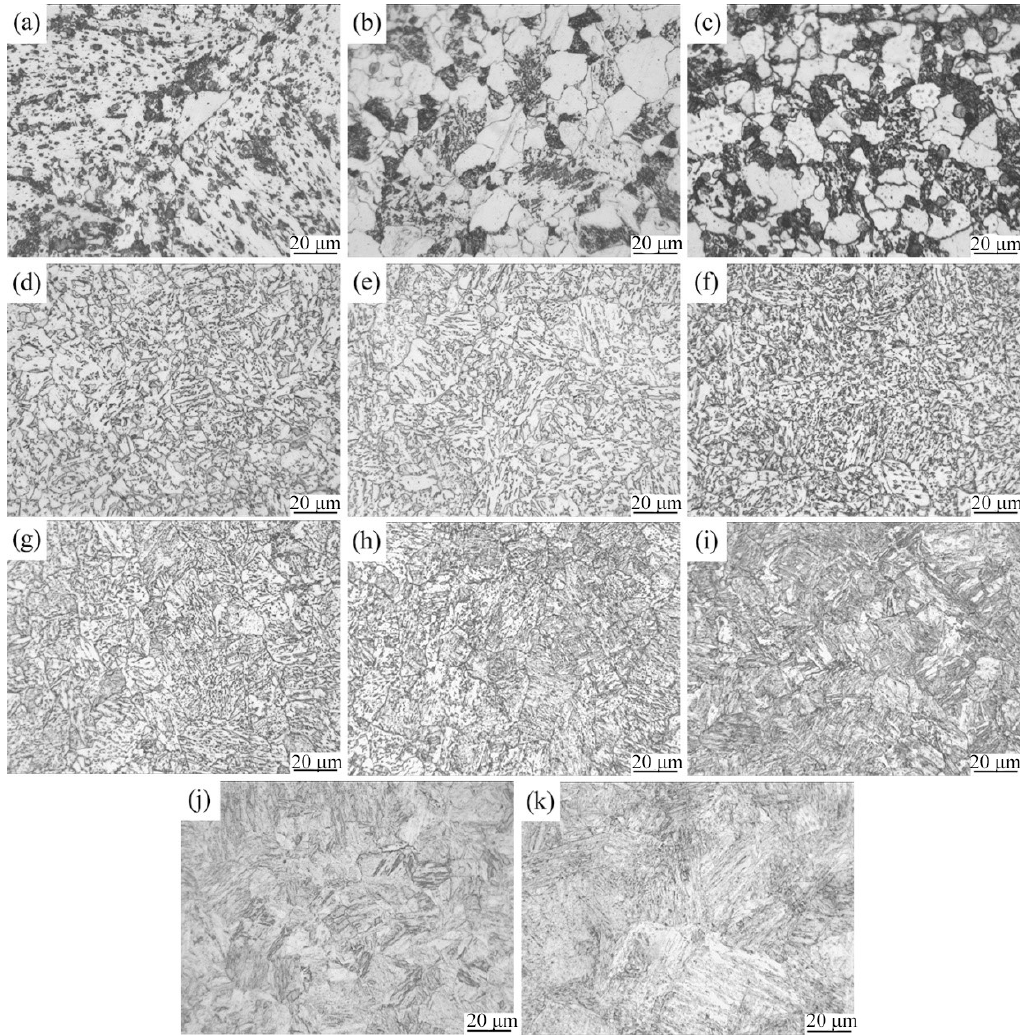
Figure 8. Metallographic microstructure of the rolled specimens at different cooling rates ( a ) original microstructure; ( b ) 0.05 °C·s − 1 ; ( c ) 0.1 °C·s − 1 ; ( d ) 0.6 °C·s − 1 ; ( e ) 1 °C·s − 1 ; ( f ) 2 °C·s − 1 ; ( g ) 3 °C·s − 1 ; ( h ) 5 °C·s − 1 ; ( i ) 10 °C·s − 1 ; ( j ) 35 °C·s − 1 ; ( k ) 50 °C·s − 1 .